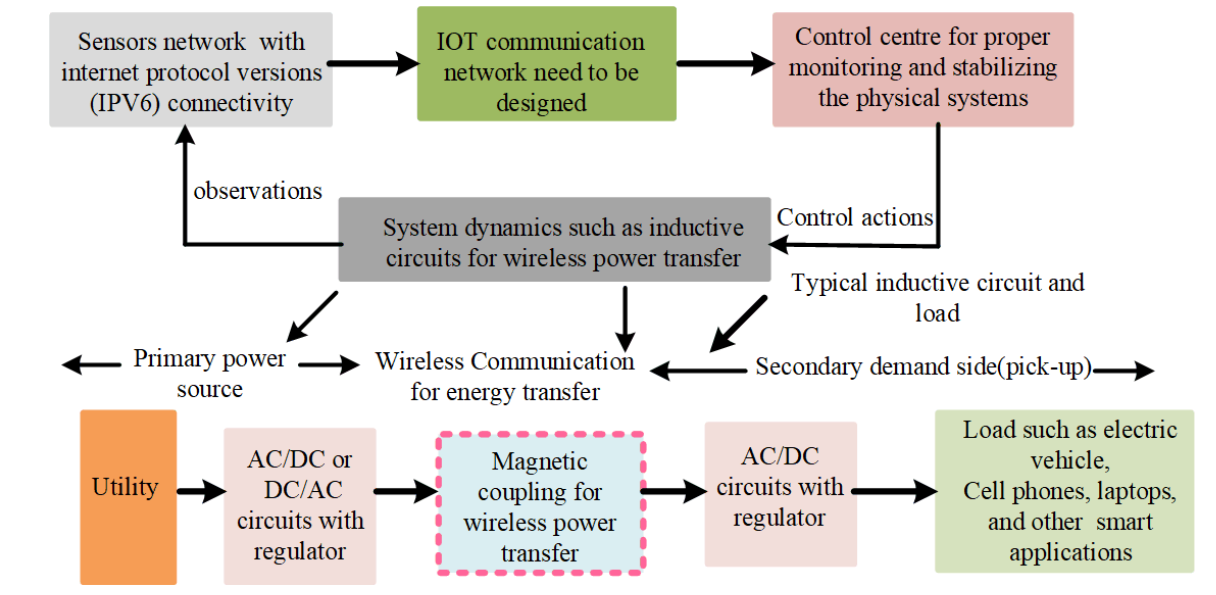
Figure 18. Functional diagram of Internet of Things on Wireless Power Transfer.